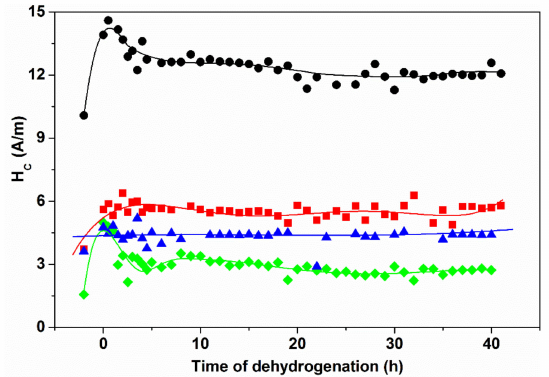
Figure 36. Change of coercivity H c in FINEMET-type alloys during dehydrogenation. Adopted from [130], with permission from Springer Nature,